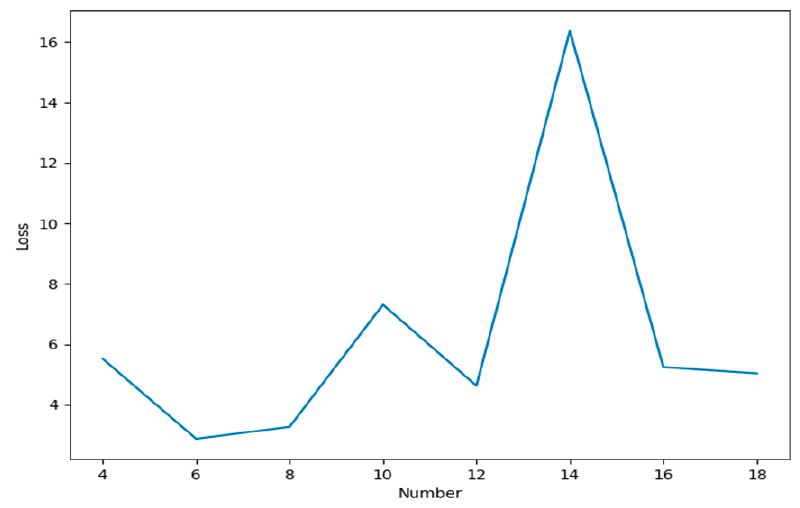
Figure 7. The influence of the different number of neurons on the result.